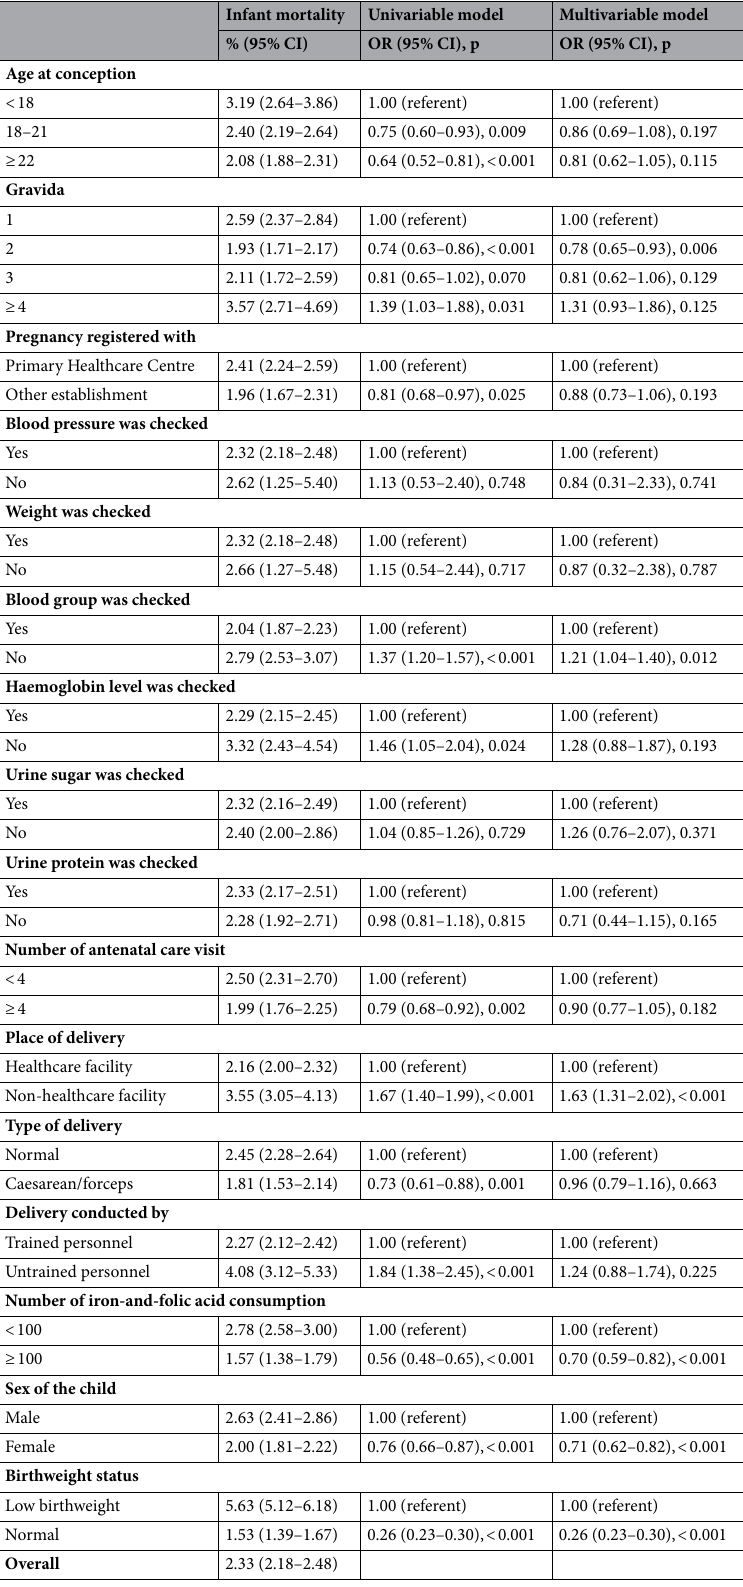
Table 3. Factors associated with infant mortality. CI confidence interval, OR odds ratio, p level of